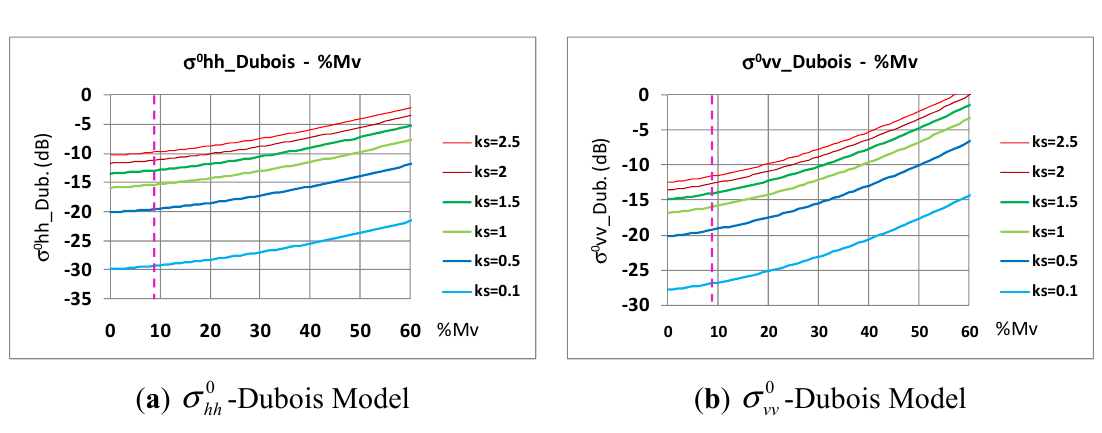
σ due to soil volumetric moisture according to different Figure 11. ( a , b ) Variations of 0 pp soil roughness degrees (ks ≡ k σ ), Oh and Dubois